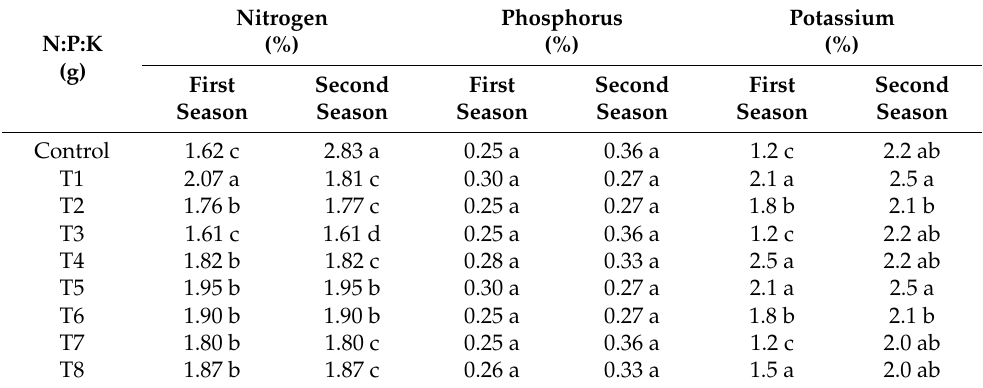
Table 1. Effect of NPK doses on the vegetative parameters’ percentage of nitrogen, phosphorous, and potassium contents in Salvadora persica .